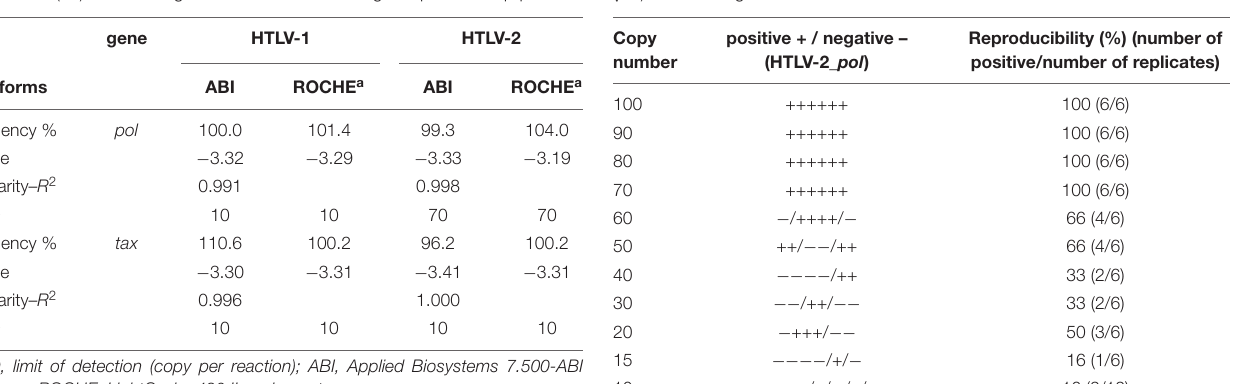
TABLE 3 | Limit of detection and intra-assay reproducibility of the mqPCR_HTLV ( pol ) for detecting